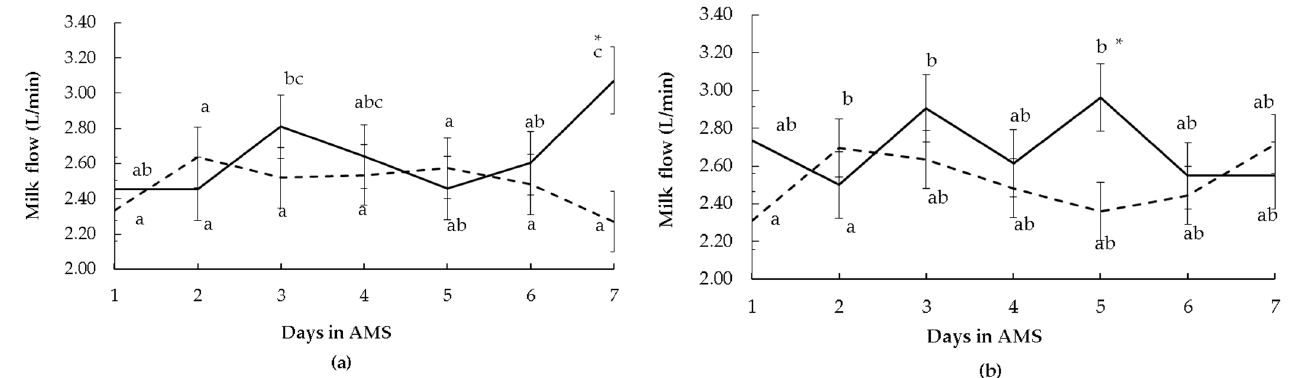
Figure 4. Milk flow (mean ± SE) of multiparous Holstein cows during seven days after the changeover from the conventional milking system (CMS) to the automatic milking system (AMS) according to ( a ) race time and ( b ) flight speed test in the CMS (calm: curt line, reactive: solid line). Differences between days are indicated with different letters, and differences between temperament classes within the same days are indicated with * ( p ≤ 0.05).